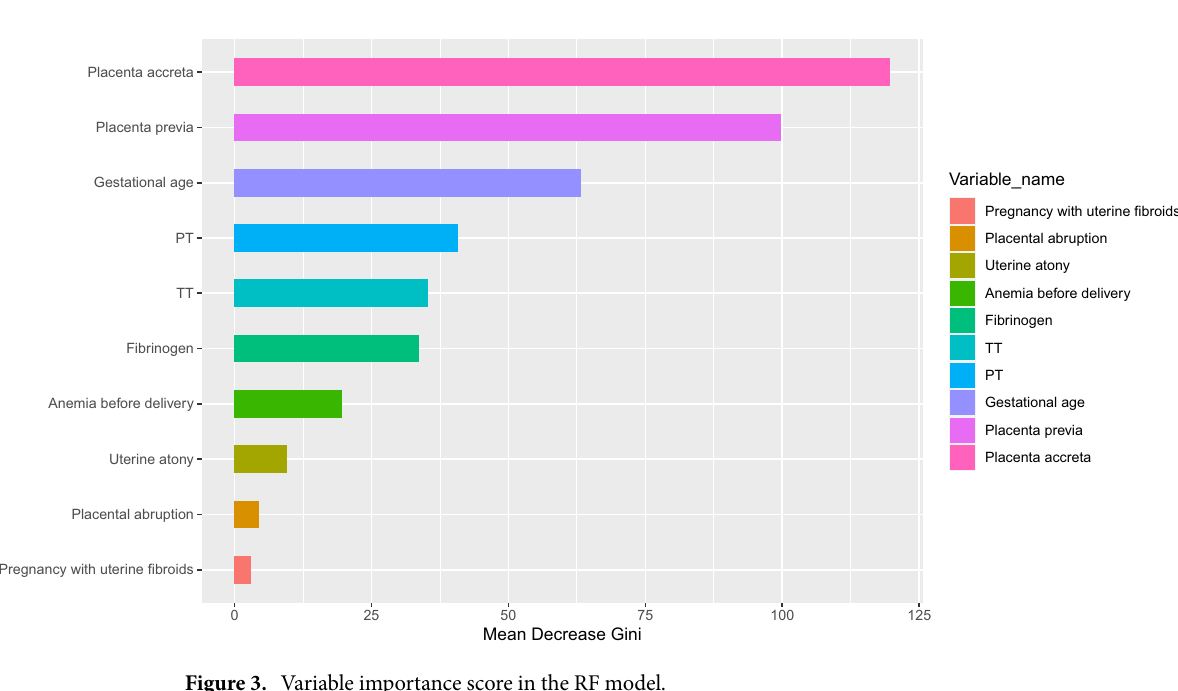
Figure 2. AUC values for five models in the training and test sets.